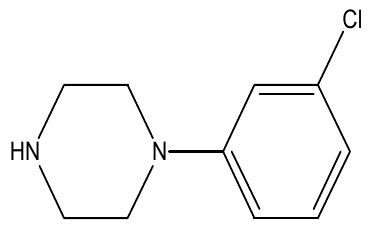
Figure 1. 1-(3-chlorophenyl)piperazine (mCPP).